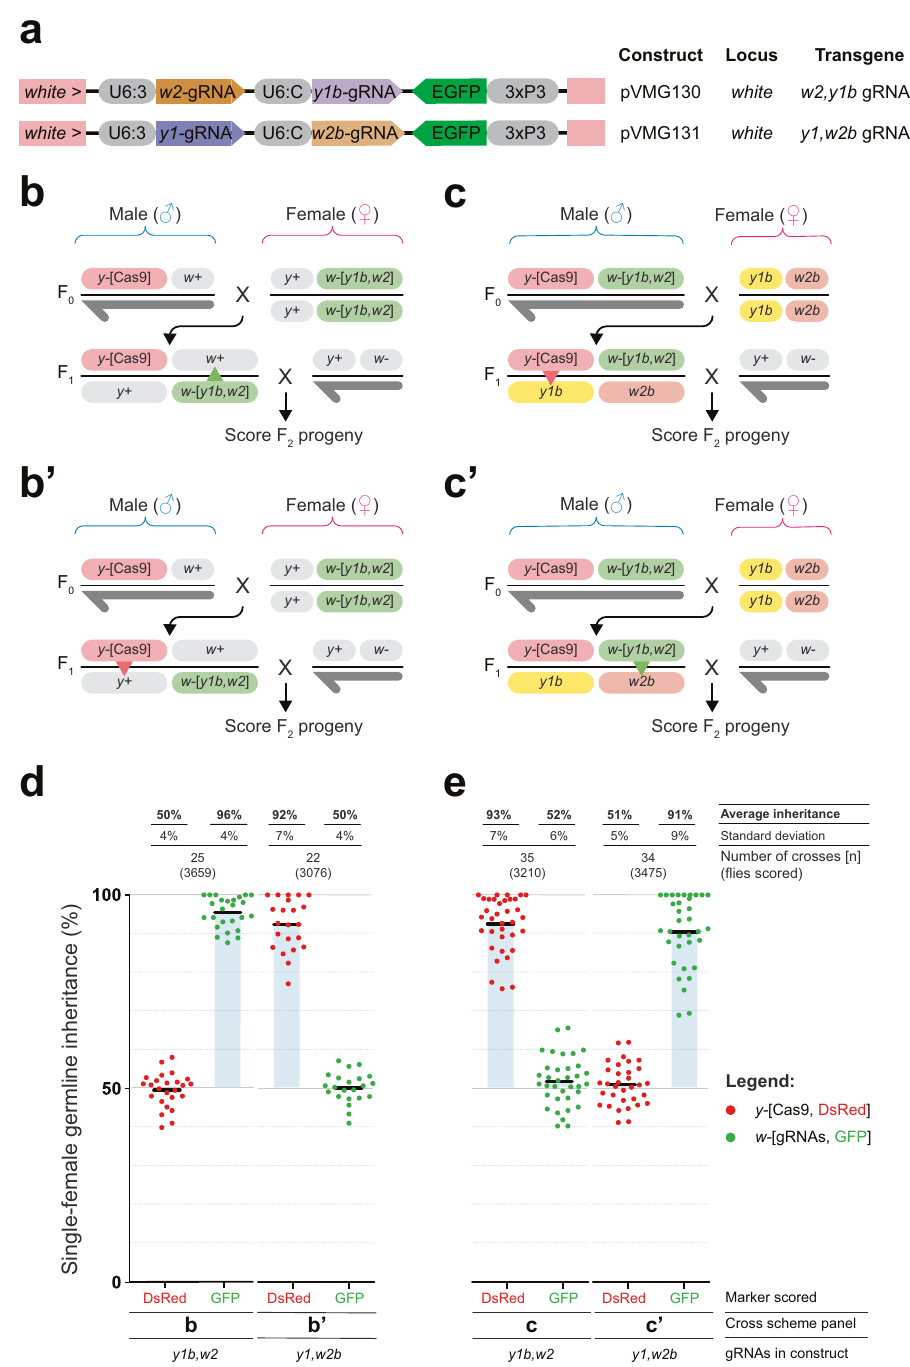
Fig. 3 Speci fi city analysis of the gRNAs used in the double-tap system. a Transgenic fl y lines generated to test speci fi city of gRNAs. Different combinations of gRNAs driven by U6 promoters are marked with 3xP3-EGFP and inserted at the white locus — the same as all other gRNA lines used in this work. b , b ’ Cross scheme used for experiments in panel d . Males carrying DsRed-marked Cas9 inserted at the yellow locus are crossed to virgin females carrying one of the two GFP-marked gRNA elements inserted at the white locus. Trans-heterozygous F 1 virgin females are single-pair crossed to wild-type males, and the resulting F 2 progeny are scored for red and green fl uorescence as markers of transgene inheritance. Symbols are the same as Fig. 1c. c , c ’ Cross scheme used for experiments in panel e . F 0 males carrying both the DsRed-marked Cas9 transgene and one of the two GFP-marked gRNA elements are crossed to virgin females homozygous for y1b (yellow box) and w2b (light brown box) alleles, which are single base pair deletions at each locus targetable by the y1b - and w2b -gRNAs, respectively. Heterozygous F 1 virgin females are crossed to wild-type males and the resulting F 2 progeny are scored for red and green fl uorescence as markers of transgene inheritance. d Single female germline inheritance rates as measured by scoring fl uorescence in F 2 progeny. Results from the b , b ’ crosses. Graph labeled as in Fig. 1e. e Same as d for the results obtained from the c , c ’